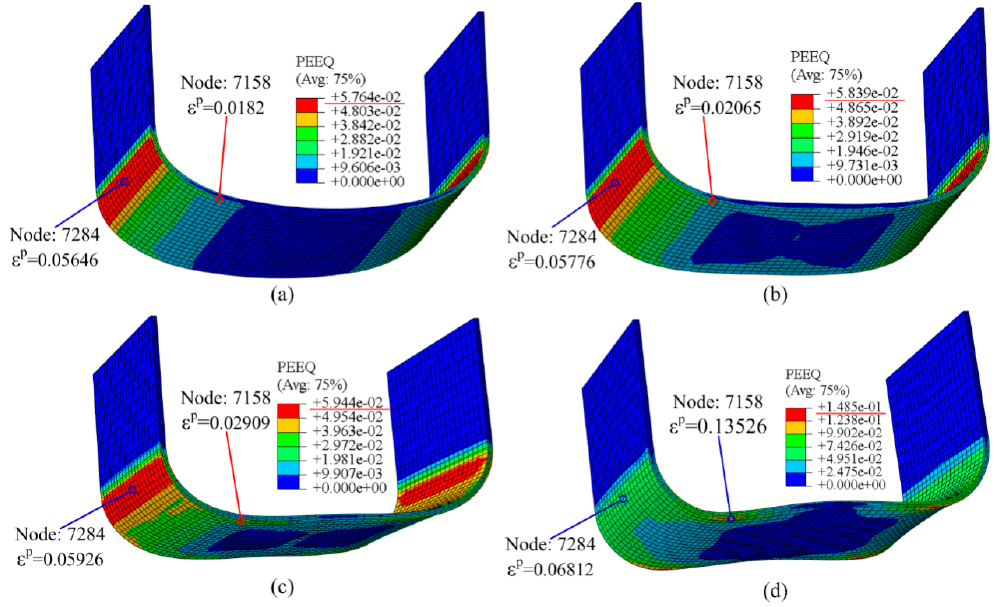
Figure 13. Equivalent plastic strain. ( a ) Quasi-static stamping; ( b ) 1.5 kV; ( c ) 2 kV; ( d ) 3 kV.